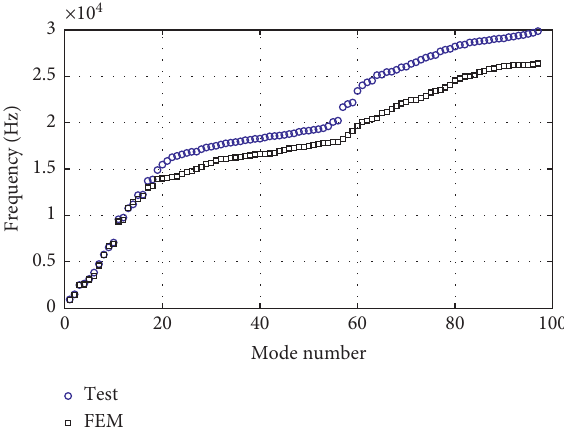
Figure 11: Modal frequencies of measurements and